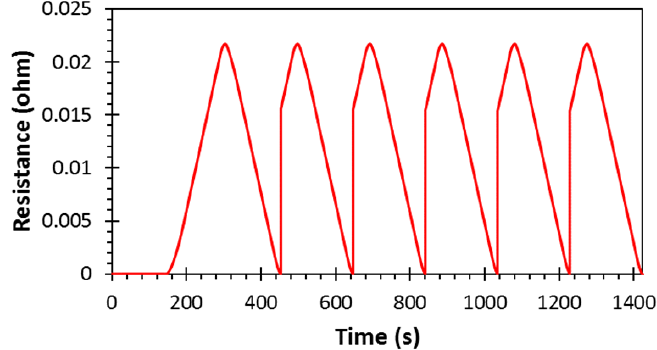
Figure 10. The electrical resistance difference between Train 2 and the train behind or the previous passenger station.